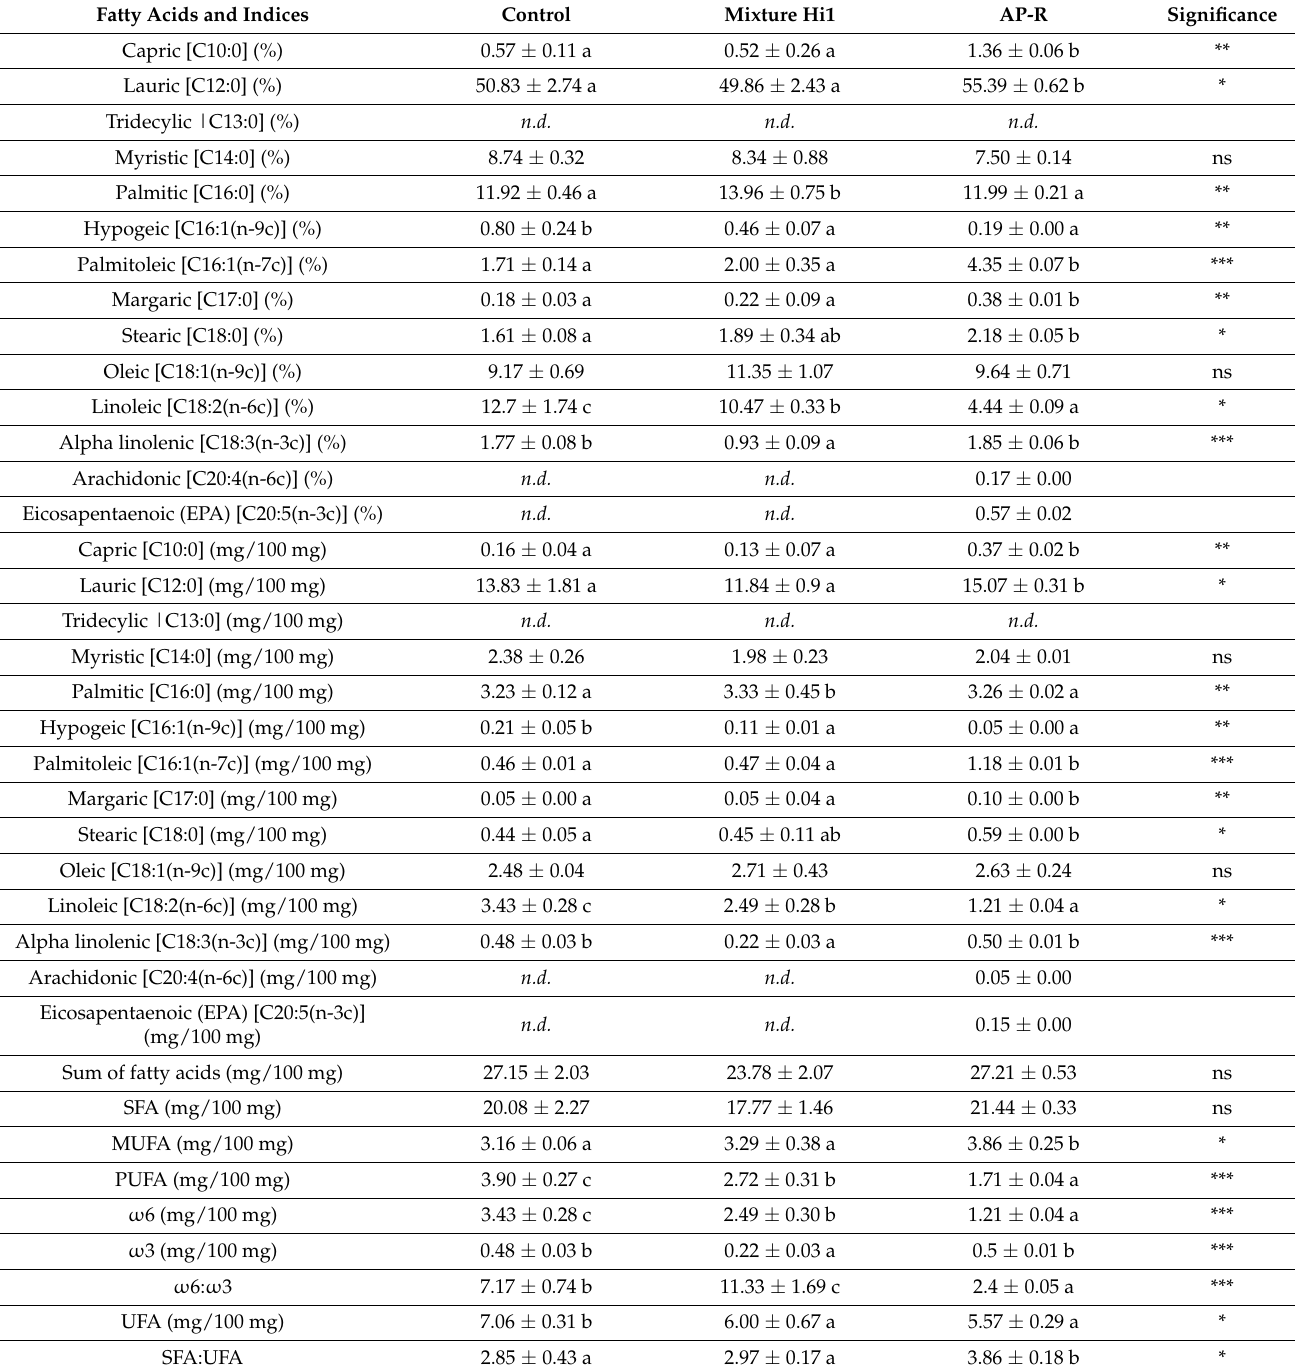
Table 2. Percentages and concentration (means ± standard deviation) of fatty acids in H. illucens larvae as a function of the diet. Results are expressed per dry matter (DM). Means within a row with different letters differ significantly (* p ≤ 0.05; ** p ≤ 0.01; *** p ≤